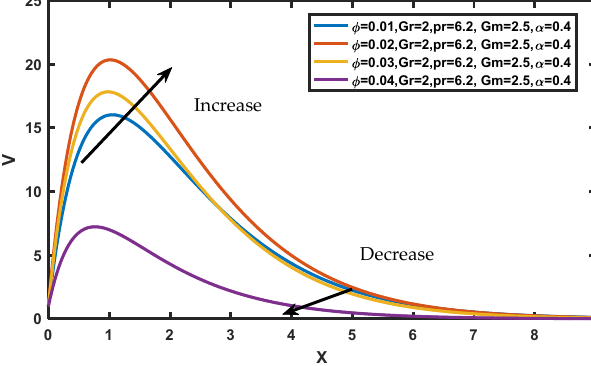
Figure 5. Variation of φ in v .